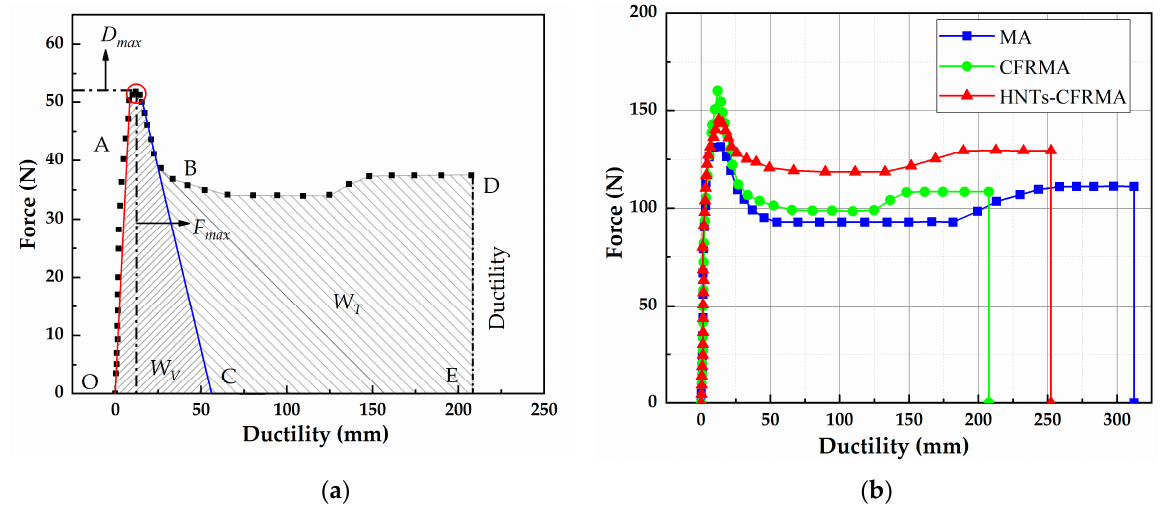
Figure 9. Characterization of asphalt low temperature performance based on force ductility: ( a ) Schematic diagram of force ductility; and ( b ) Force and displacement curve of asphalt.